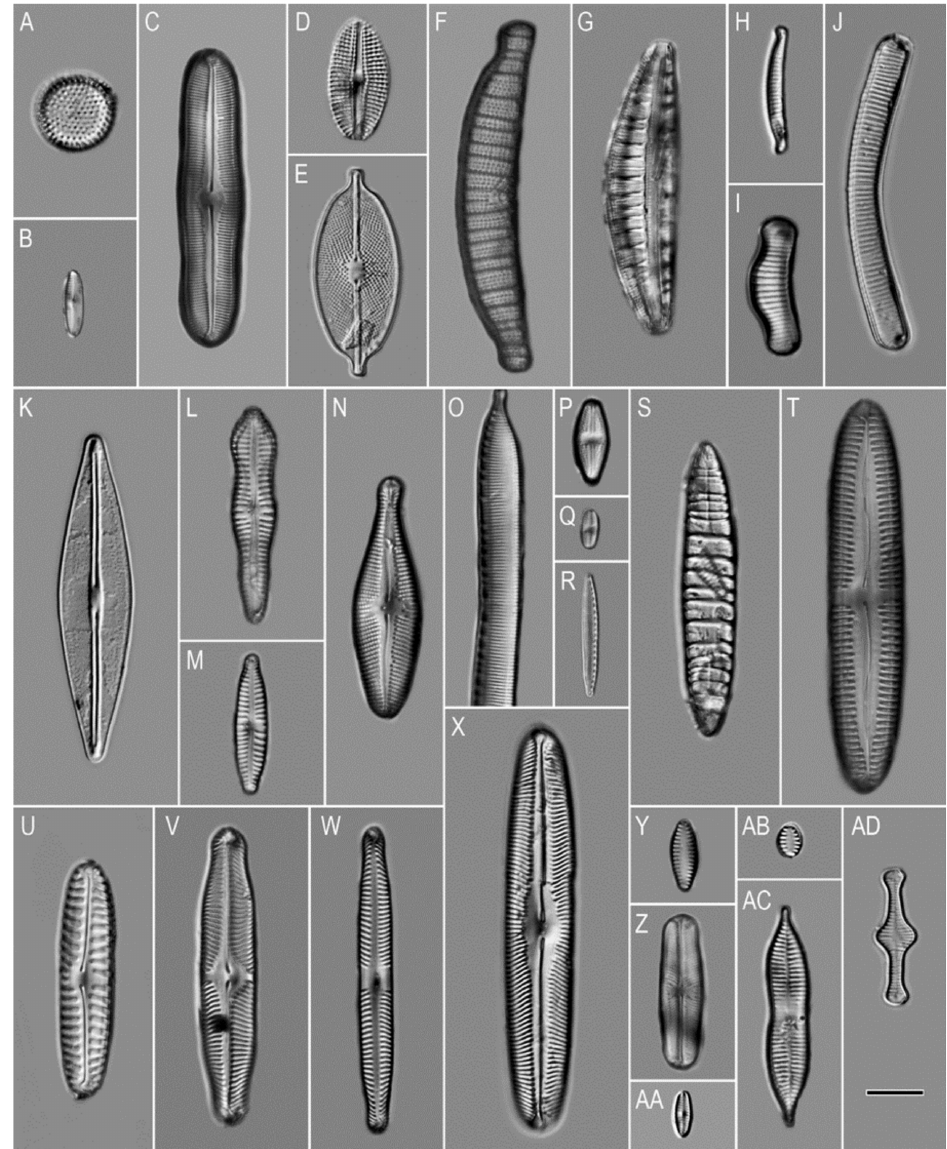
Figure 3. Species of diatoms from soils near the Malki, Upper Paratunka and Dachnie thermal springs. ( A )— Aulacoseira distans ; ( B )— Caloneis lancettula ; ( C )— Caloneis silicula ; ( D )— Diploneis calcilacustris ; ( E )— Decussiphycus placenta ; ( F )— Epithemia adnata ; ( G )— Epithemia operculata ; ( H )— Eunotia arcus var. fallax ; ( I )— Eunotia curtagrunowii ; ( J )— Eunotia sp.; ( K )— Frustulia krammeri ; ( L )— Gomphonema brebissonii ; ( M )— Gomphonema sp. ; ( N )— G. ventricosum ; ( O )— Hantzschia cf. abundans ; ( P )— Luticola acidoclinata ; ( Q )— Navicula minima ; ( R )— Nitzschia hantzschiana ; ( S )— Odontidium hyemale ; ( T )— Pinnularia substreptoraphe ; ( U )— P. borealis ; ( V )— P. microstauron ; ( W )— P. cf. subcapitata ; ( X )— P. cf. subrupestris ; ( Y )— Pseudostaurosira brevistriata ; ( Z )— Sellaphora rectangularis ; ( AA )— S. seminulum ; ( AB )— Staurosira venter ; ( AC )— Synedra goulardii ; ( AD )— Tabellaria flocculosa . Scale bar—10 µ